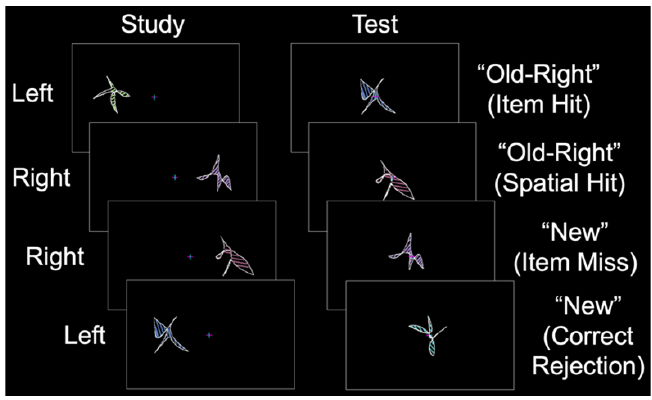
Figure 2. Behavioral protocol. During the study phase, abstract shapes were presented in the left or right visual field (labeled to the left). During the test phase, old and new shapes were presented at the center, and participants made “left”, “right”, or “new” judgments (illustrative responses shown to the right with corresponding response types in parentheses).